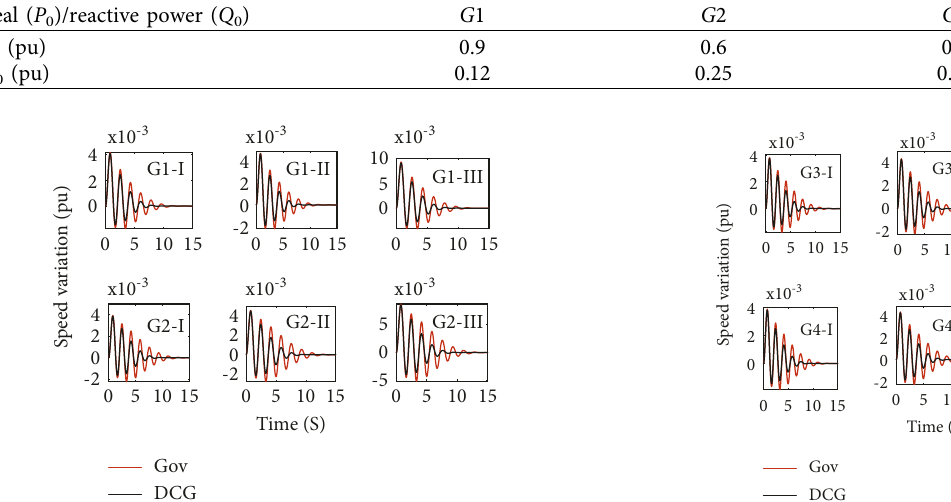
Figure 10: Angular frequency variation for G